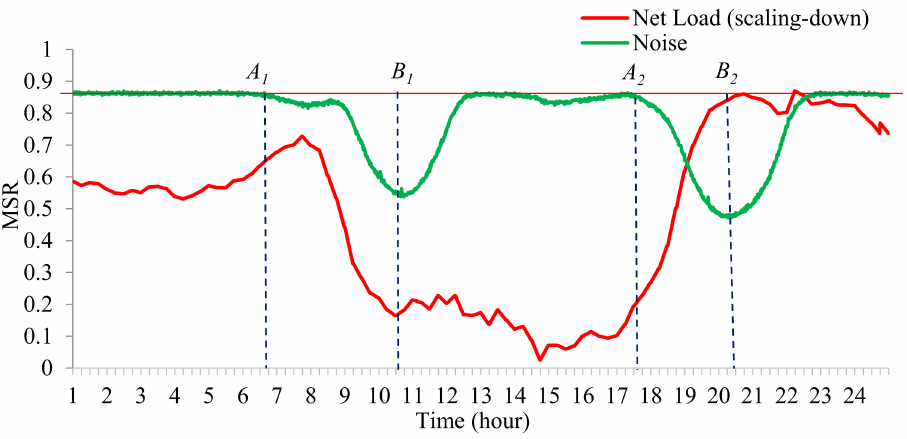
Figure 9. MSR analysis and time division for 20 April.